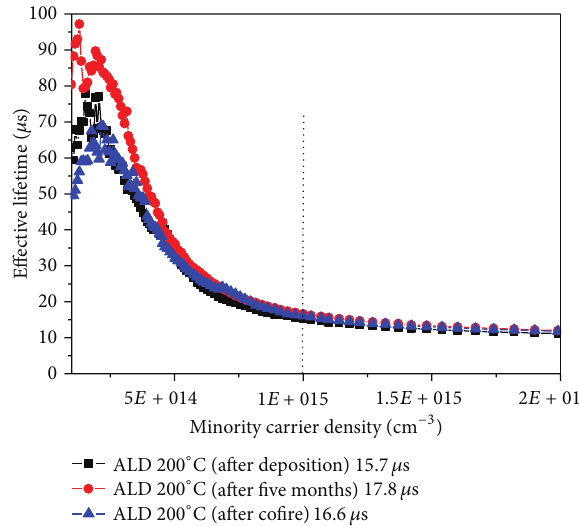
Figure 6: Effective minority carrier lifetime of 30 nm TiO 2 thin films deposited at 200 ∘ C in threecases: after deposition, five months, and cofire.